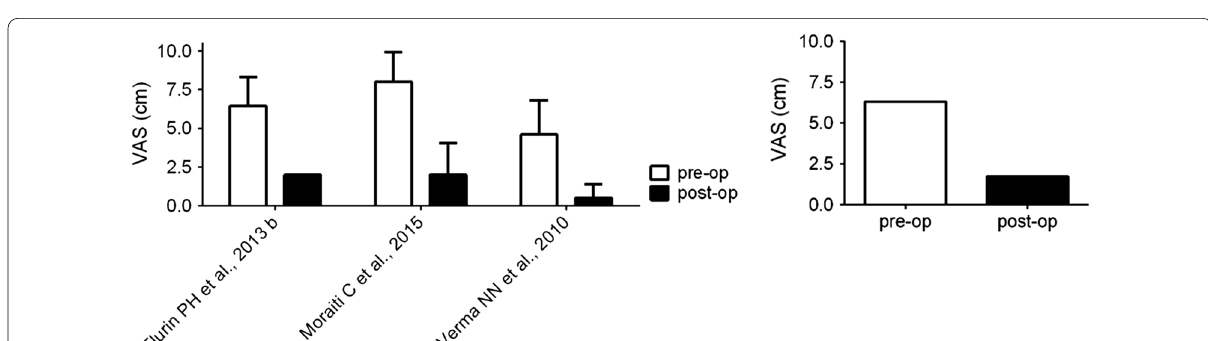
Fig. 2 Comparison of CMS in pre- and postoperative populations. Left: mean CMS values reported in the analyzed studies; Right: weighted average value of CMS. CMS, Constant Murley Score; pre-op, preoperative; post-op, postoperative